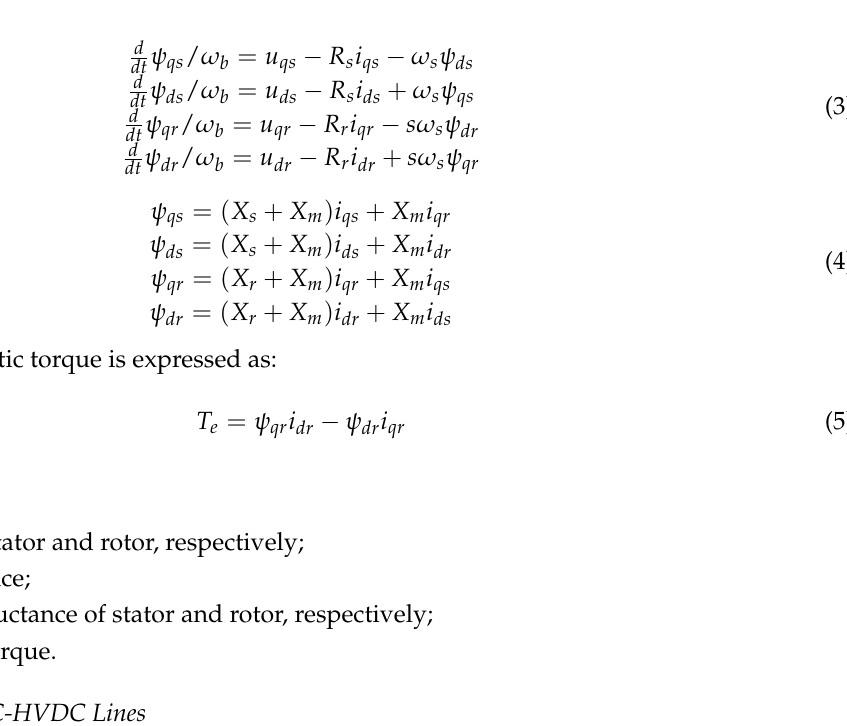
Figure 3. Equivalent circuit of a squirrel cage induction generator ( a ) d-axis ( b ) q-axis.